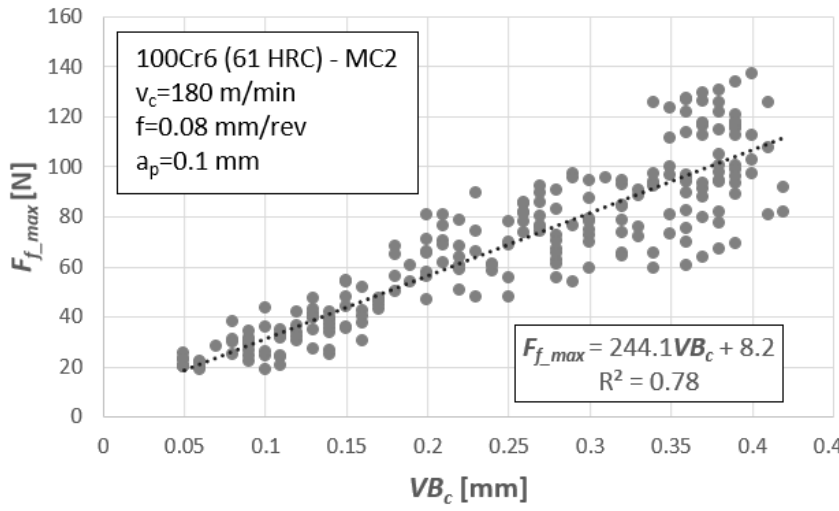
Figure 3. Feed force, Ff_max, as a function of flank wear, VBc , for all 15 cutting wedges.